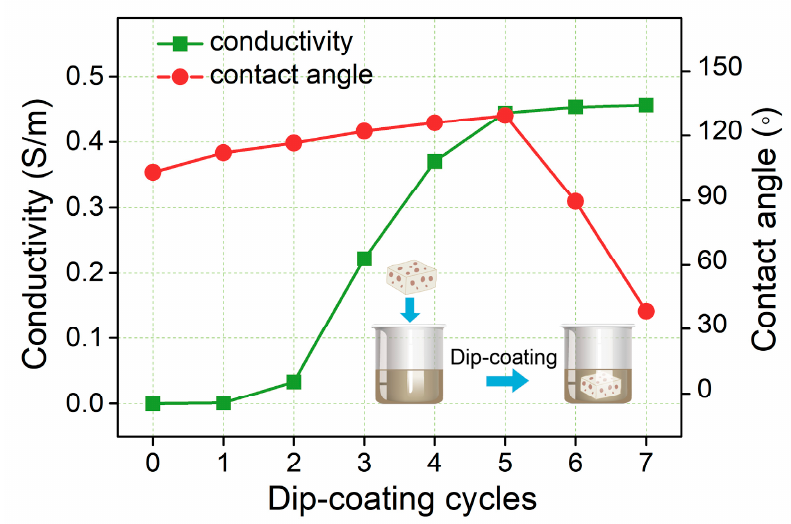
Figure 6. Conductivity and contact angle of AgNWs ‐ NRLF with different dip ‐ coating cycles. ∆𝑅/𝑅 (cid:3404) (cid:4666)𝑅 (cid:3398) 𝑅(cid:4667)/𝑅 represented relative resistance variation, in which 𝑅 (cid:2868) (cid:2868) (cid:2868)